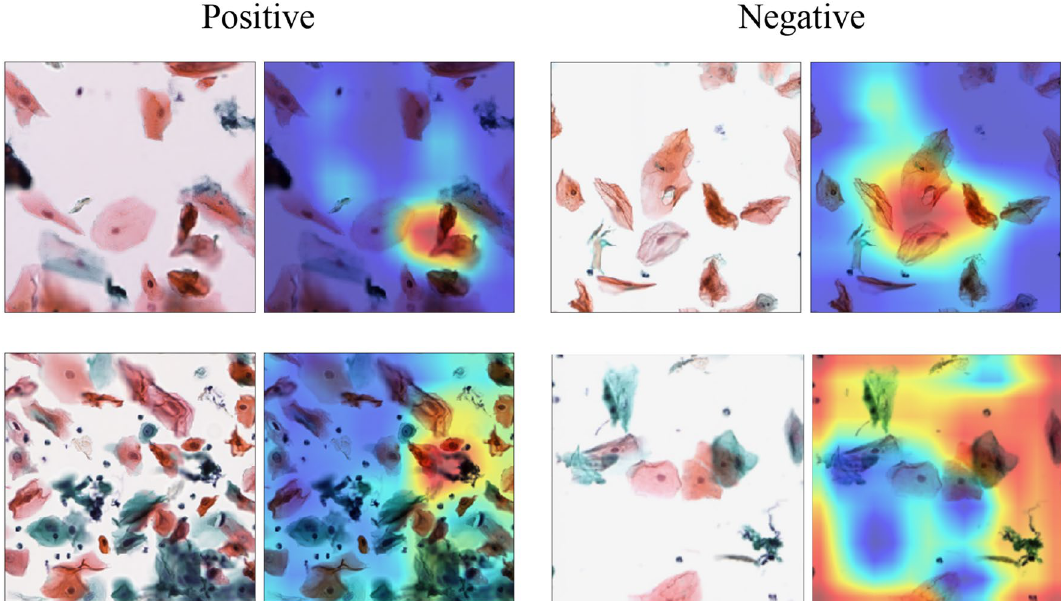
Figure 3. Visualization of regions of interest for CNN classification in oral exfoliative cytopathology classification. In the heat map visualization, the warmer the color, the greater the effect on label